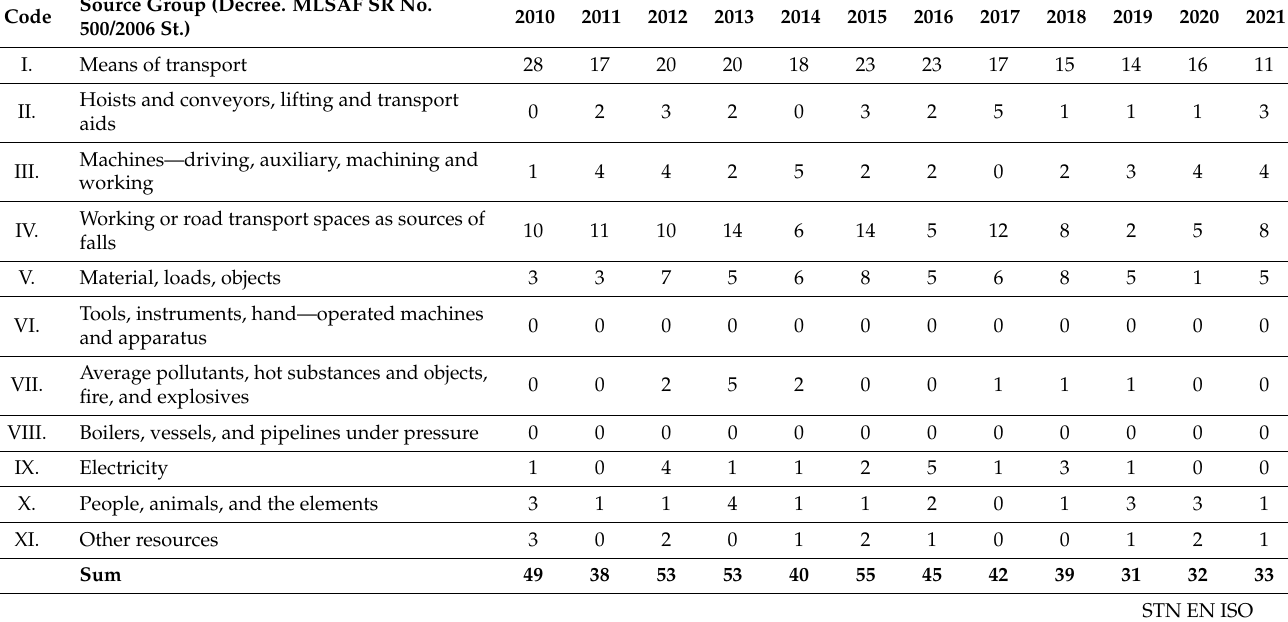
Table 5. Share of main groups of resources in the total number of fatal accidents at work in organiza- tions in the years 2010–2021 [31]. Source Group (Decree. MLSAF SR No. Code 500/2006